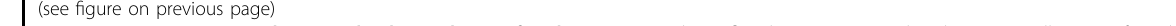
Fig. 6 SIRT1 activates autophagy via the deacetylation of Beclin1. A In autophagic fl ux determination and analysis, HK-2 cells were infected with an adenovirus expressing mRFP-GFP-LC3 (magni fi cation ×630 and scale bar = 20 μ m). B Mean numbers of autophagosomes (yellow dots per cell in merged images) and autolysosomes (red dots per cell in merged images) were calculated in 20 randomly selected cells ( n = 20). C The percentage of autolysosomes (free red spots/(yellow spots + free red spots) per cell) was calculated in 20 randomly selected cells to determine autophagic fl ux ( n = 20). The data are presented as the mean ± SD. *** p < 0.001 vs WT Beclin1 over-expression control (WT group); ### p < 0.001 vs the WT + LPS group. D – F Representative western blots and densitometric analysis of the autophagy-related proteins Beclin1, LC3 II and SQSTM1 ( n = 6). The data are presented as the mean ± SD. ** p < 0.01 and *** p < 0.001 vs the WT group; ## p < 0.01 and ### p < 0.001 vs the WT + LPS group. G – I Representative western blots of the autophagy-related proteins (LC3 II and SQSTM1) after SIRT1 knockdown or double mutation of Beclin1 ( n = 6). The data are presented as the mean ± SD. ** p < 0.01 vs the WT + LPS group; ## p < 0.01 and ### p < 0.001 vs the 2KR + LPS group; †† p < 0.01 and ††† p < 0.001 vs the WT + LPS + SIRT1 siRNA group. SAKI sepsis-induced acute kidney injury, LPS lipopolysaccharide, SIRT1 silent mating-type information regulation 2